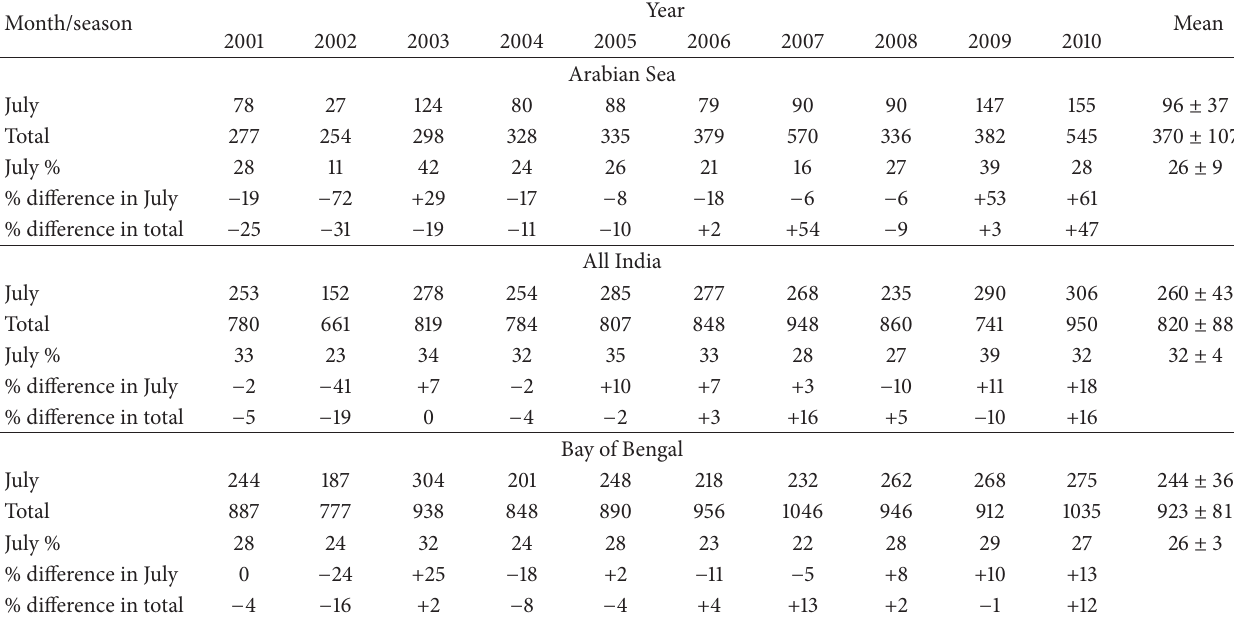
Table 1: Accumulated rainfall (mm) in July from 2001 to 2010 over the Arabian Sea, all India, and the Bay of Bengal and its mean. Total rainfall during the southwest monsoon season (June-July-August-September) and percentage contribution of July rainfall to total rainfall are given. Percentage difference in July and seasonal rainfall from the mean (2001–2010) for each year and each region is also given. Percentage difference in − indicates % deficit and + denotes % excess with respect to the mean rainfall in July or for the